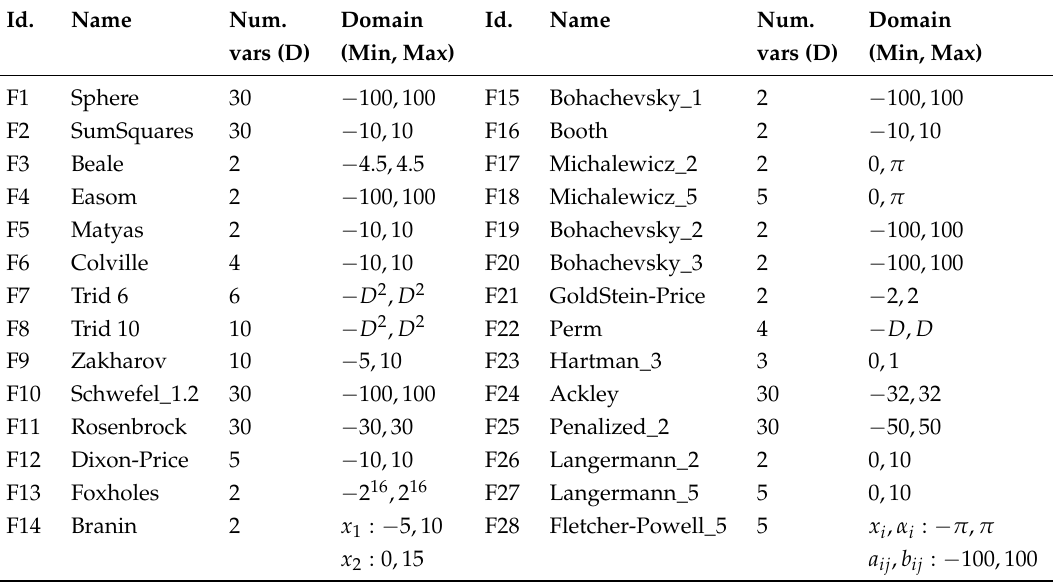
Table 1. Benchmark functions. Names and parameters.